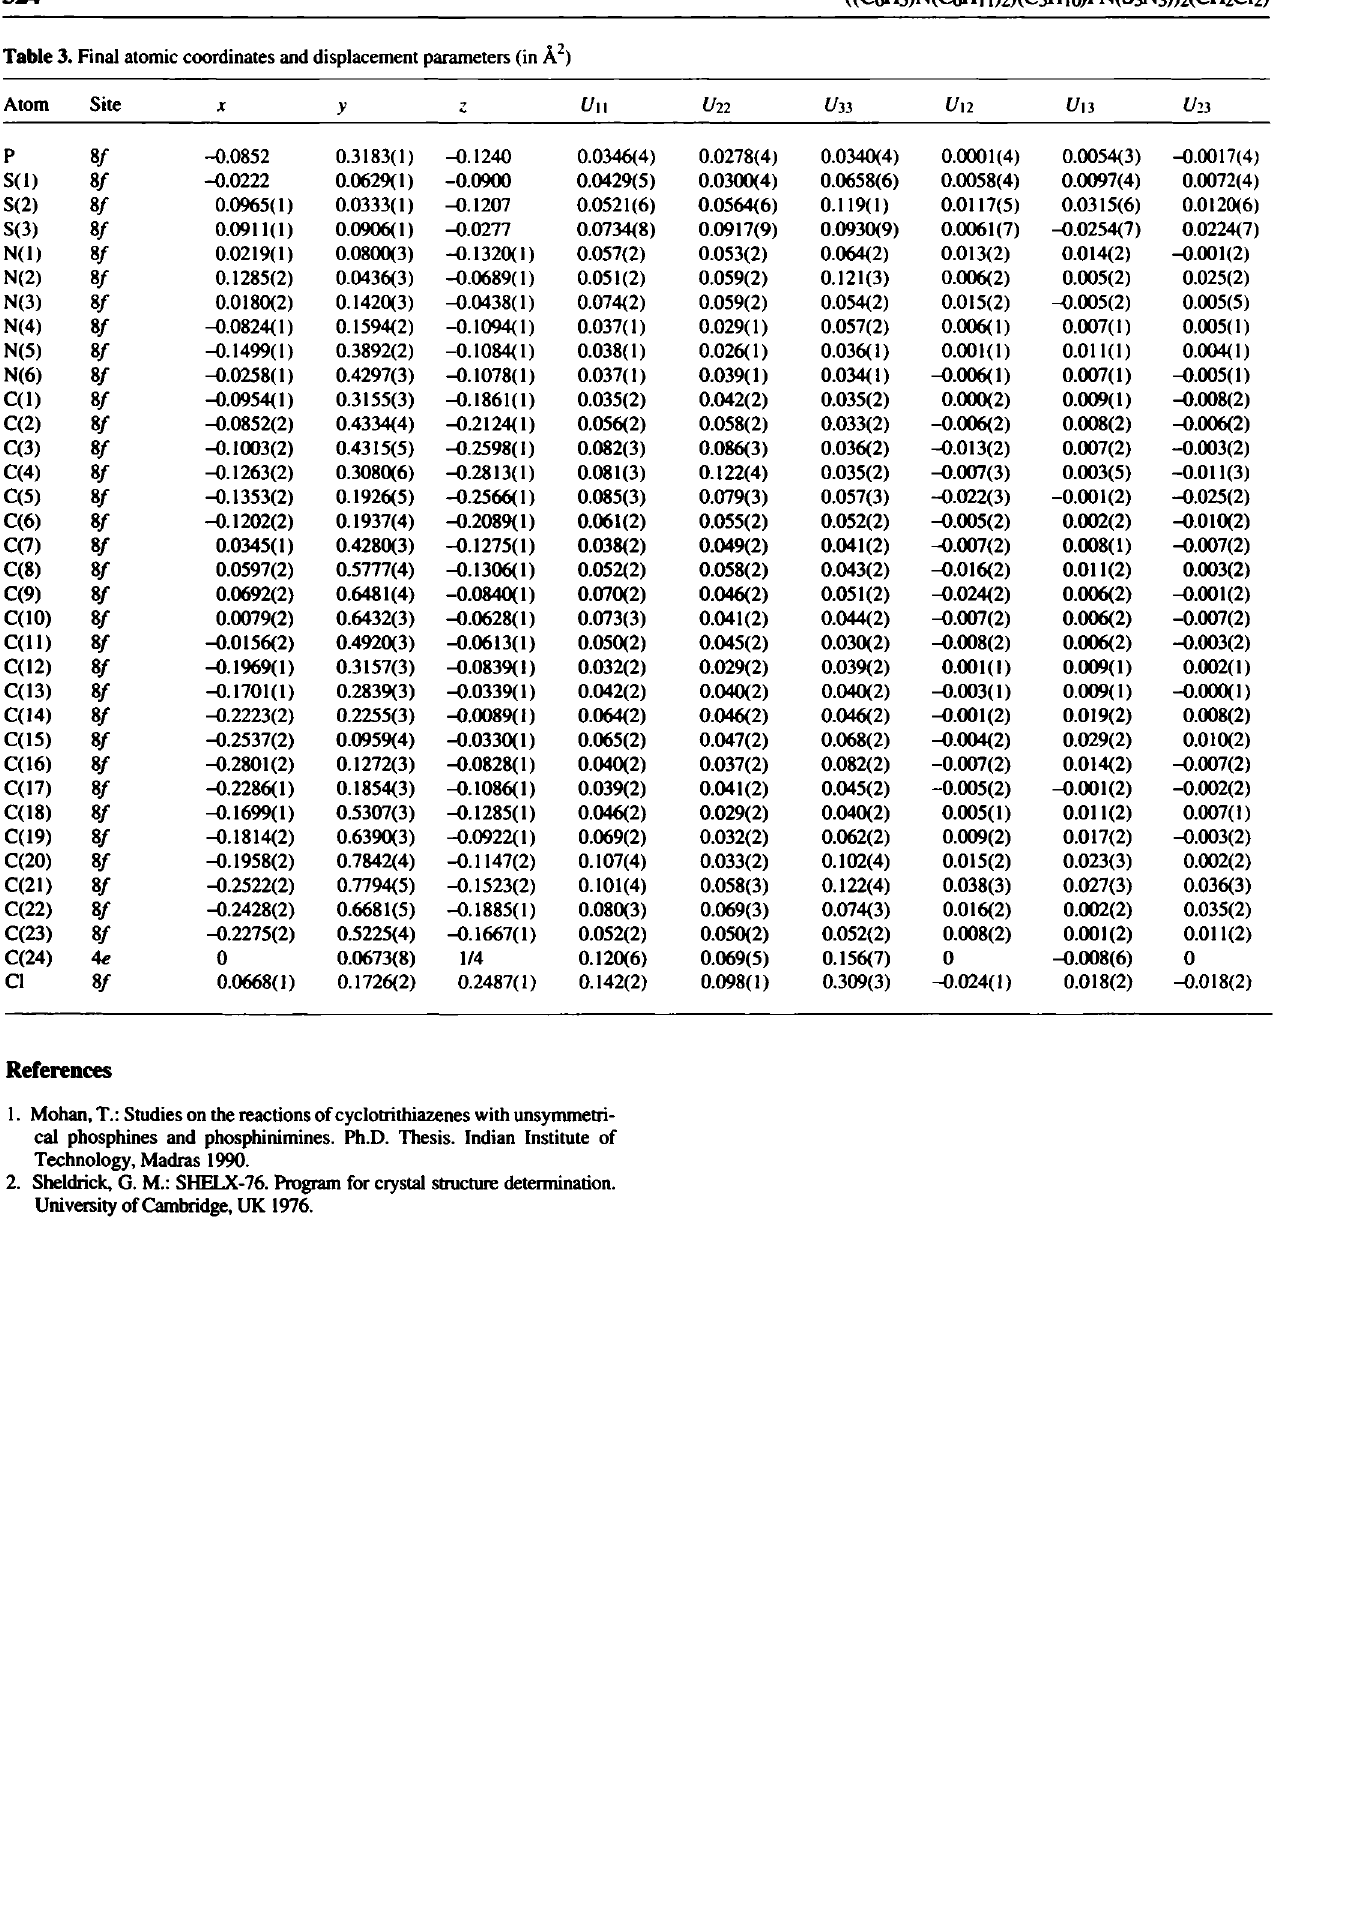
Table 3. Final atomic coordinates and displacement parameters (in Â 2